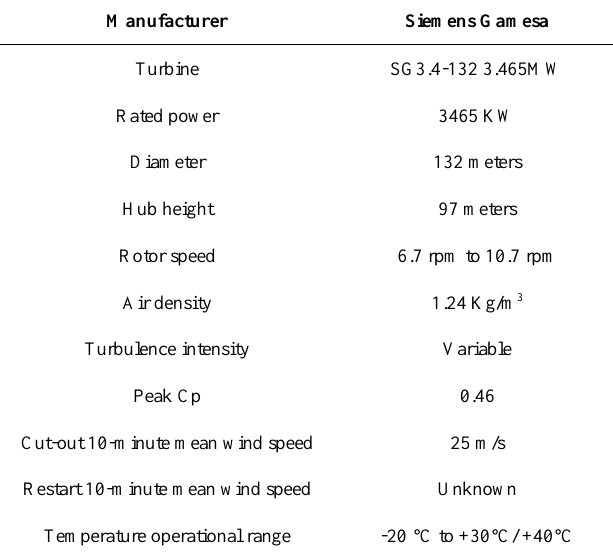
Table 1. The technical specifications of Siemens Gamesa SG3.4-132, 3.465 MW turbine